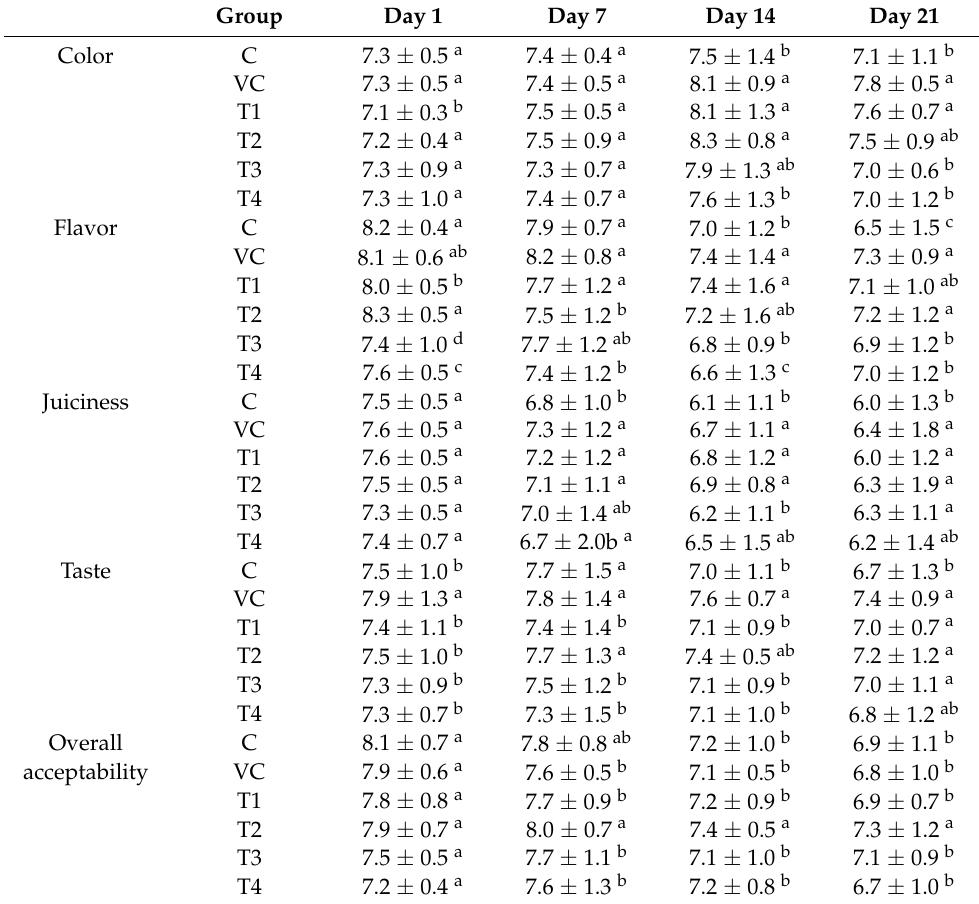
Table 7. Effect of extract addition on sensory quality of frankfurters during storage at 4 ◦ C ( n =